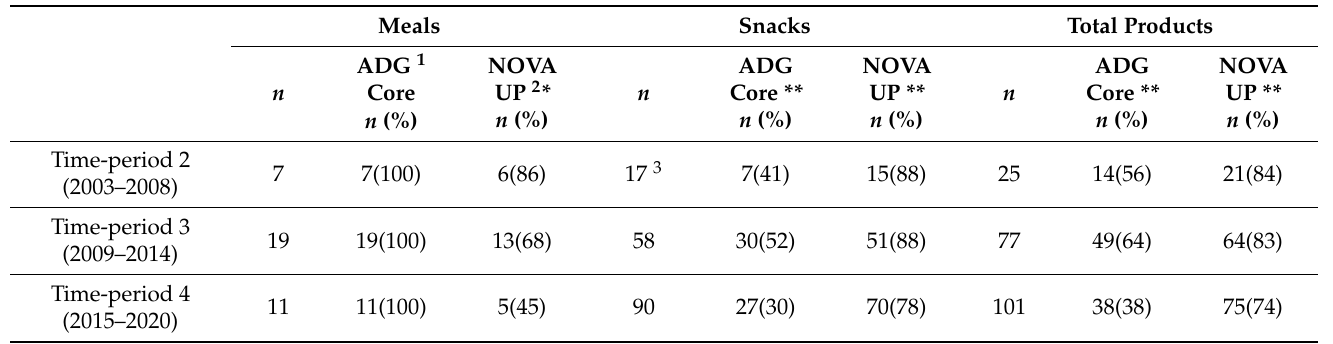
Table 1. Number of products launched in Time-periods 2-4, and classifications within ADG and NOVA.